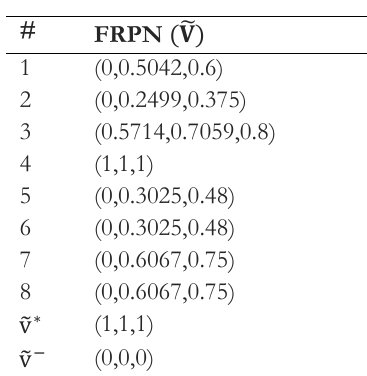
Table 5. Formation of membership function by multiplying the membership functions of severity, probability and detection.